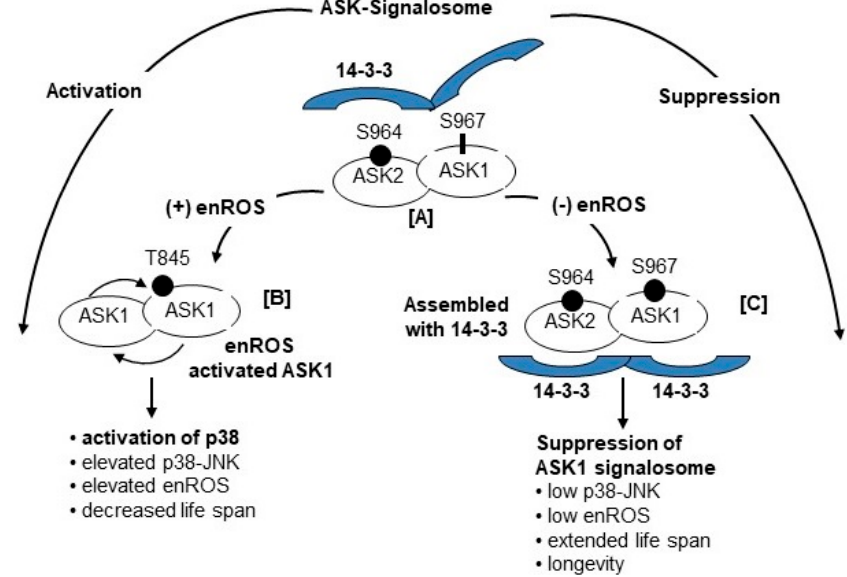
Figure 5. Regulatory process at the C-terminus14-3-3 domain of ASK1-ASK2-responses to ROS. [ A ] The heterodimer of P-ASK2-Ser 964 -ASK1 is bound to 14-3-3 via P-ASK2-Ser 964 ; [ B ] Under conditions of elevated ROS, p38 is activated via the formation of the ASK1-P-ASK1-Thr 845 complex which is released from 14-3-3; [ C ] Under conditions of decreased ROS[( − )ROS] the P-ASK2-Ser 964 stimulates the phosphorylation of ASK1-Ser 967 to form the P-ASK2-Ser 964 -P-ASK1-Ser 967 -14-3-3 complex which suppresses the ASK2-ASK1 signalosome and activation. Activation also involves the recruitment of C-terminal regulatory proteins AIP and